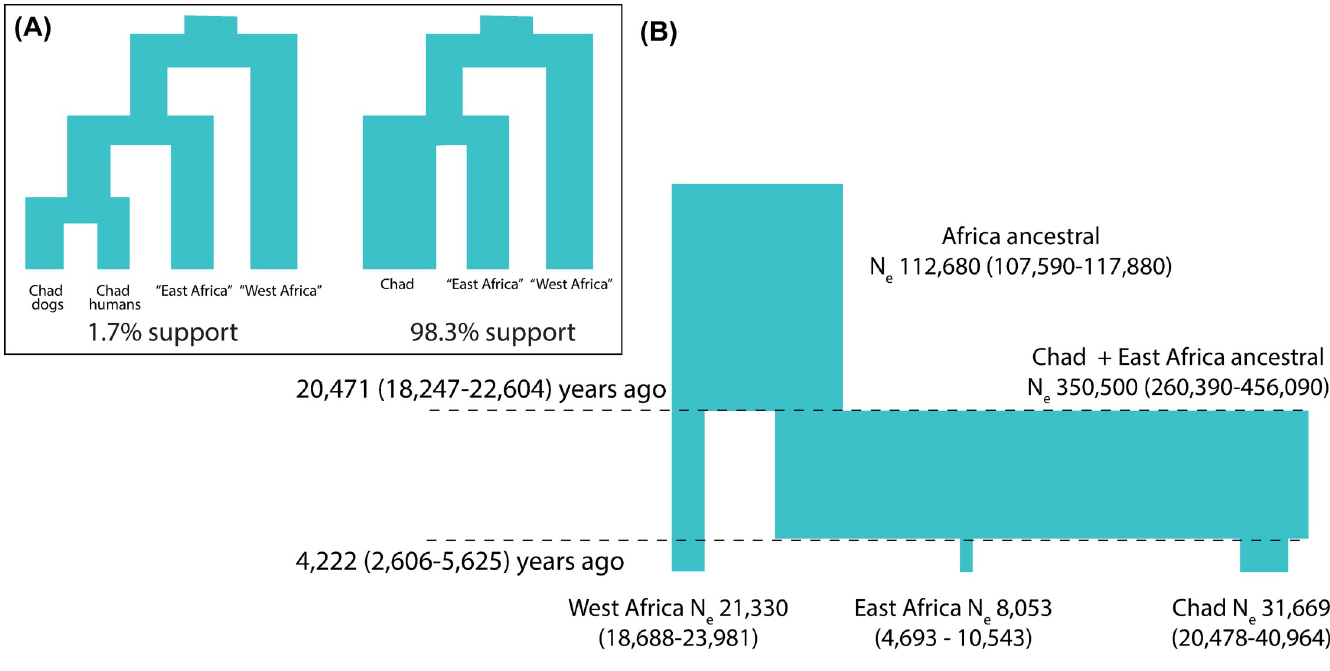
Fig 4. Coalescent models of Dracunculus medinensis population structure. (A) Out of all possible scenarios for up to 4 distinct isolated populations of D . medinensis , we find posterior support for only 2, with strong support only for a model in which all worms from Chad are part of one population, more closely related to worms from Ethiopia and South Sudan than to those from elsewhere in our sample set. (B) Estimates of divergence times and genetic (effective) population sizes under the supported model shown in (A). Values shown are posterior means and 95% highest posterior density estimates for each parameter in this model, under one set of prior